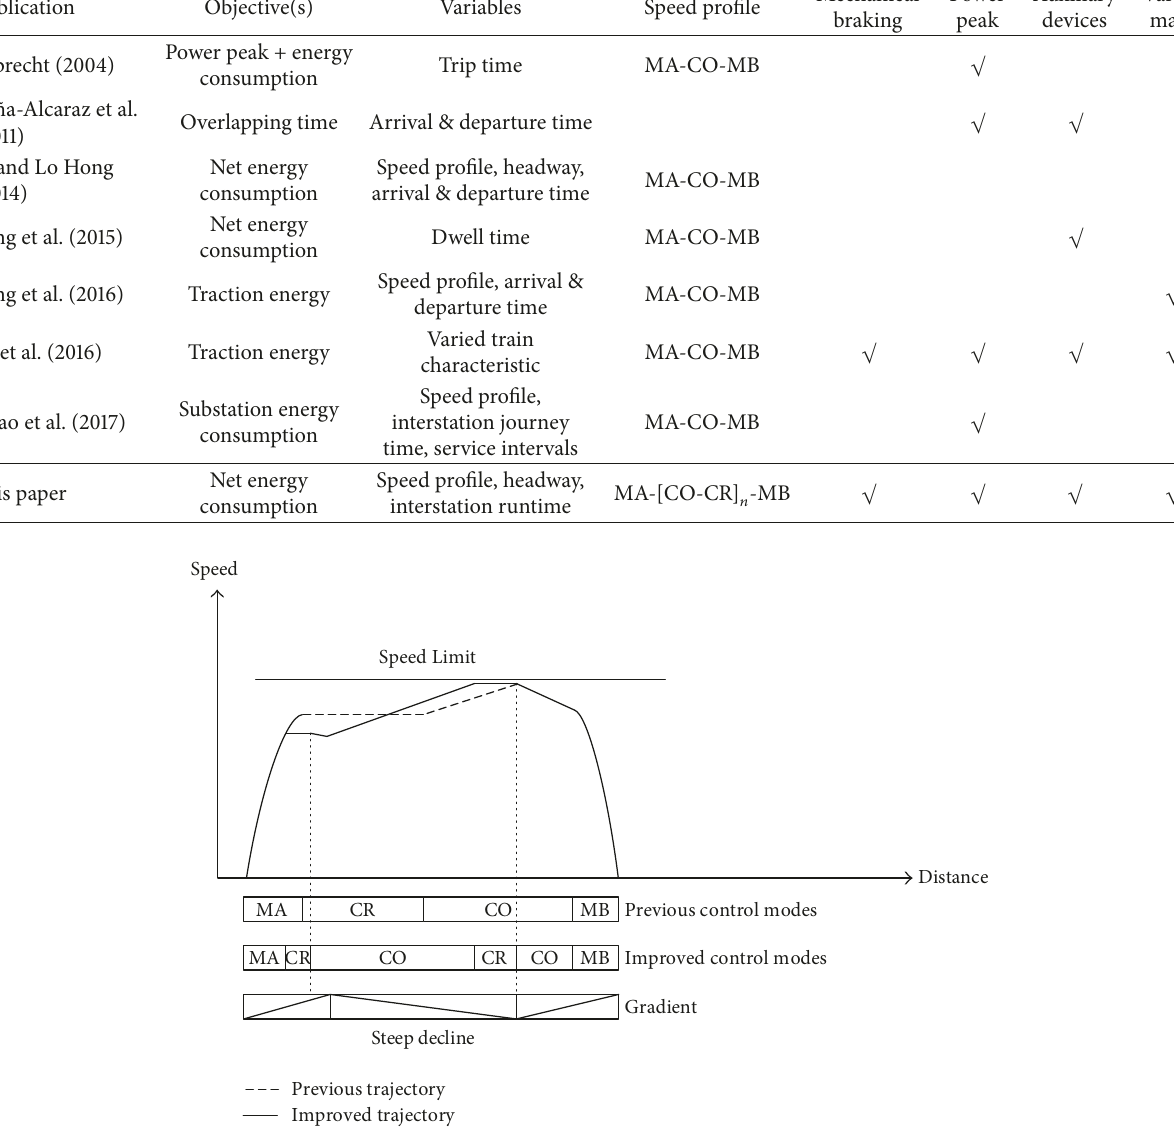
Figure 1: The improvements of the energy-efficient train control